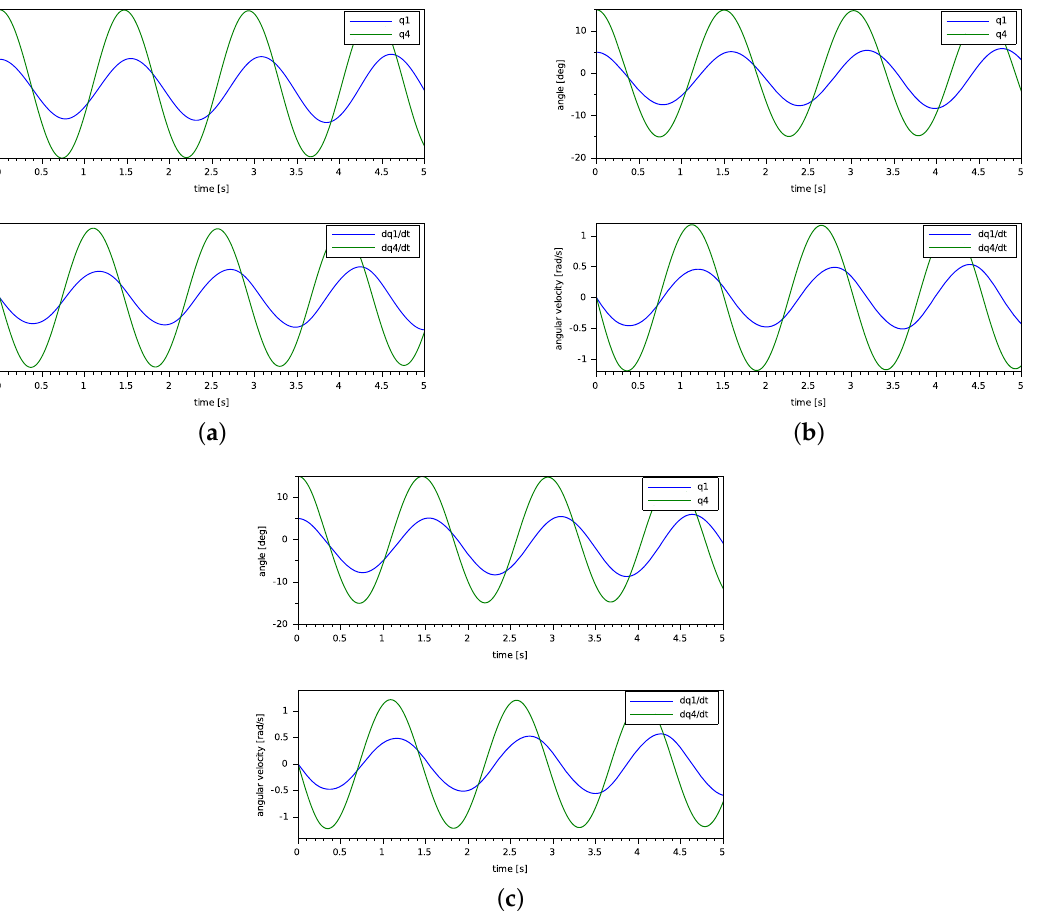
Figure 7. Direct dynamics: generalized coordinates and velocities of joints 1 ( q 1 , dq 1 / dt ) and 4 ( q 4 , dq 4 / dt ) simulated for subjects of different heights and weights: ( a ) 1.8 m and 80 kg; ( b ) 1.7 m and 60 kg; ( c ) 1.6 m and 50